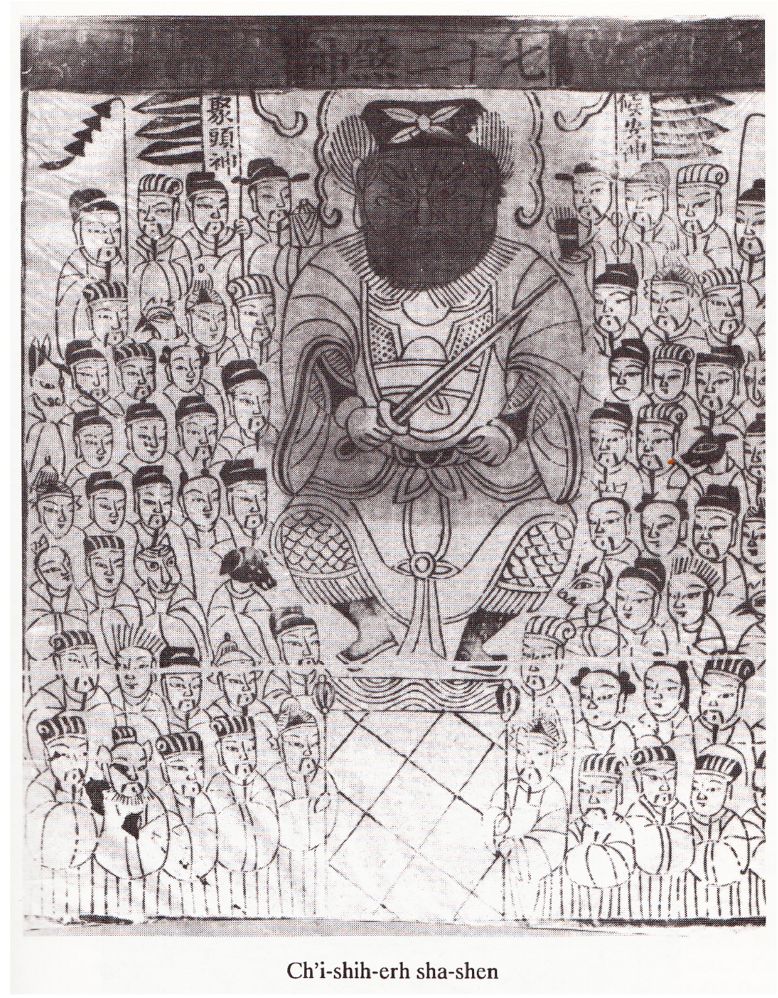
Figure 2. The 72 Killers depicted on a paper print. From: Goodrich, Peking Paper Gods .